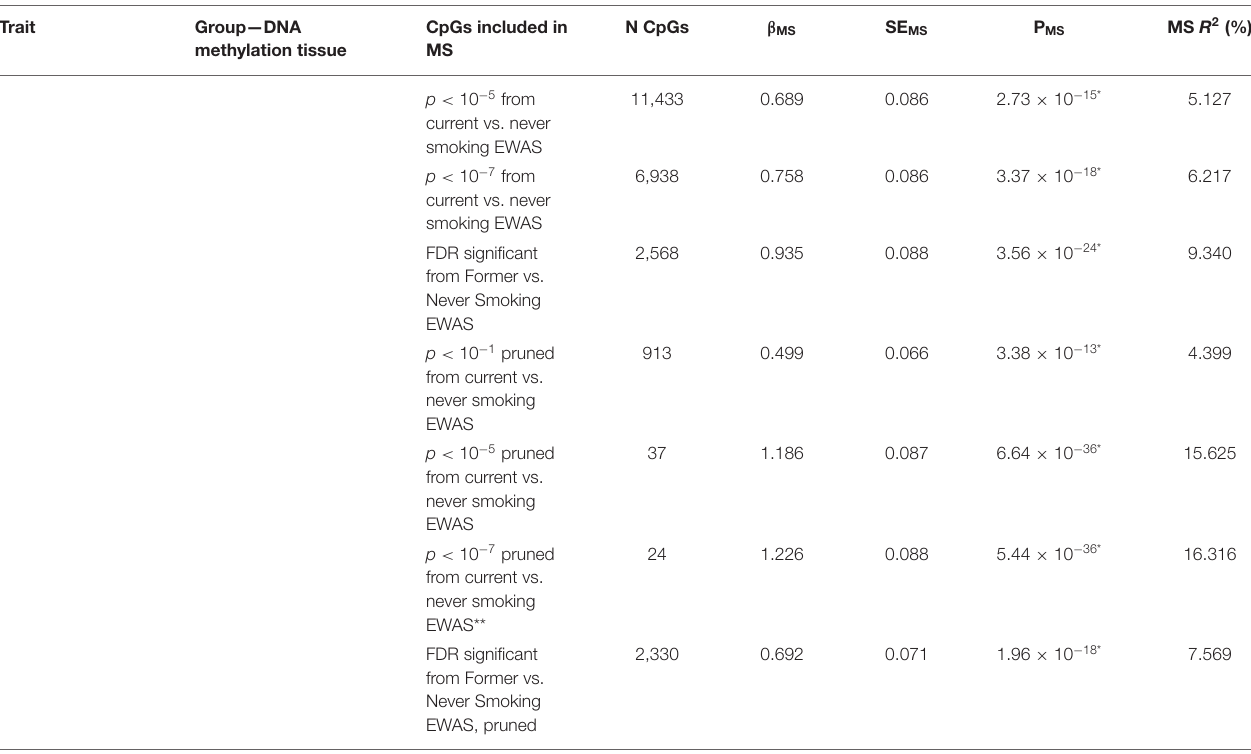
Trait Group—DNA methylation tissue